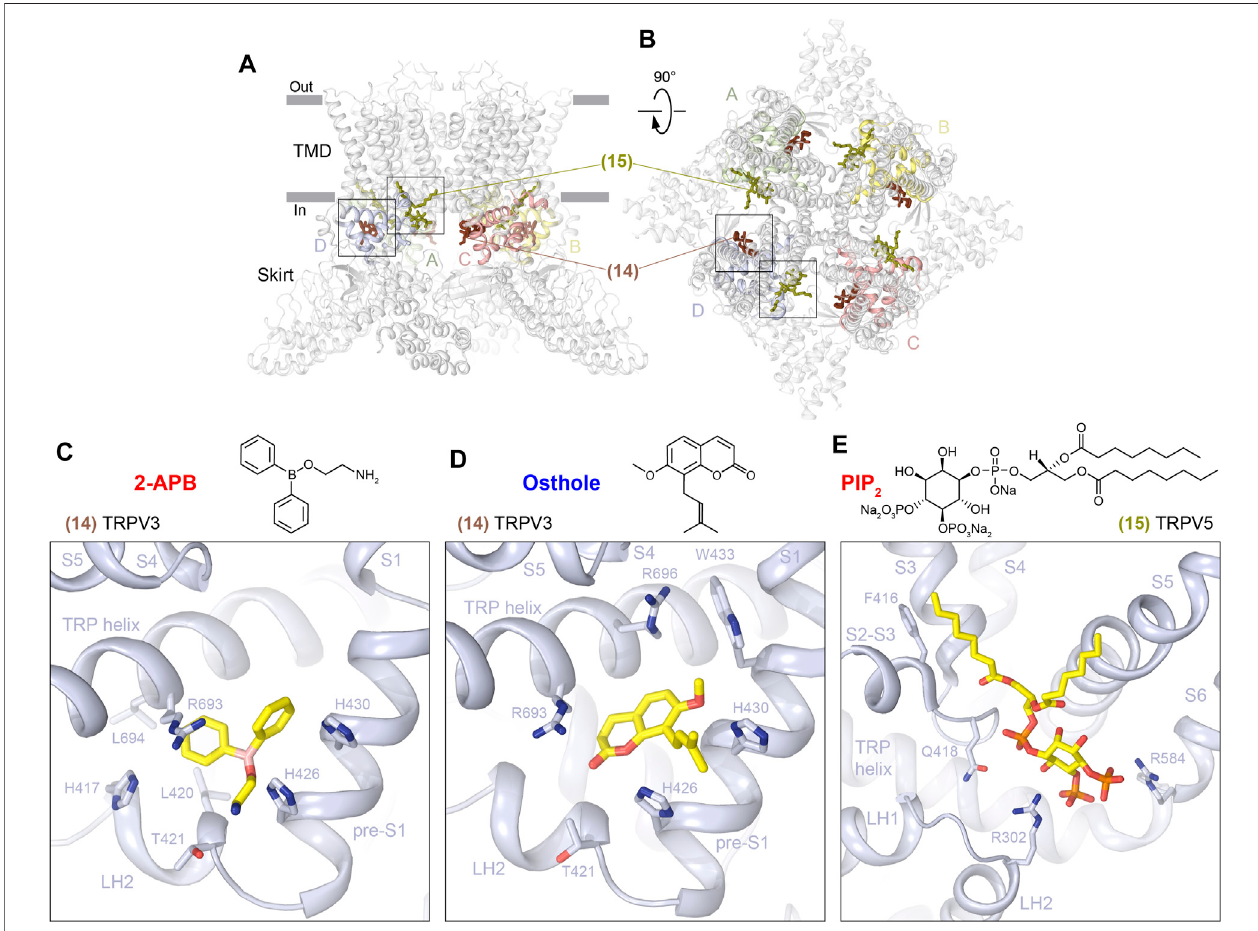
FIGURE 7 | ARD – TMD interface sites. (A – B) Side (A) and top (B) views of the TRPV1 tetramer (gray; PDB ID: 7LQY) with the ARD-TMD linker (14) and S2-S3 (15) sitesillustratedbyligandsinbrownandolive,respectively.Rectanglesindicatetheregionsexpandedinclose-upviews. (C – E) Close-upviewsoftheARD-TMDlinkersite inTRPV3withbound2-APB( C ,PDBID:6DVZ)orosthole( D ,PDBID:7RAS)andtheS2-S3siteinTRPV5withboundPIP 2 ( E ,PDBID:6DMU).Residuescontributingto ligand binding are shown in sticks. The chemical structures of the corresponding ligands are shown above the close-up